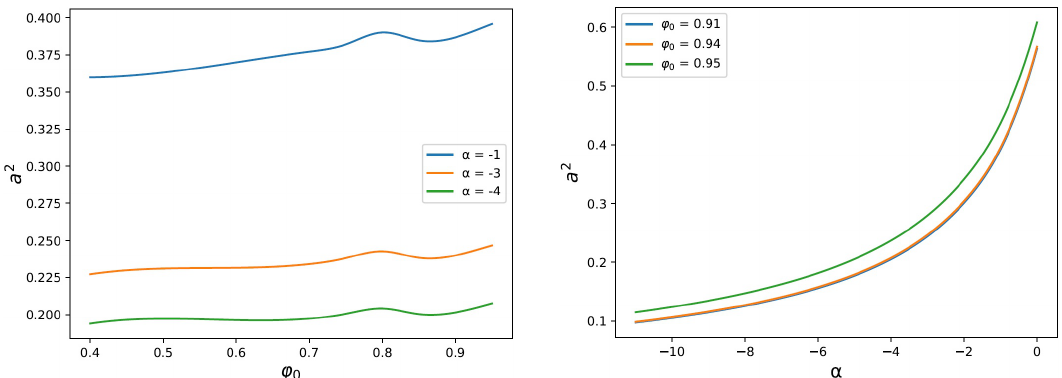
Figure 9 . Left: the squashing parameter a 2 as a function of ϕ 0 for fixed values of α for Nut end-point solutions. Right: the squashing parameter a 2 as a function of α for fixed values of ϕ Nut end-point